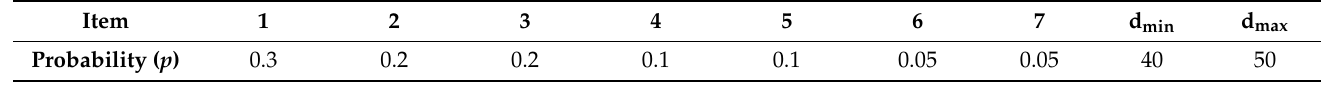
Table 3. Probability distribution of the demand for seven items.